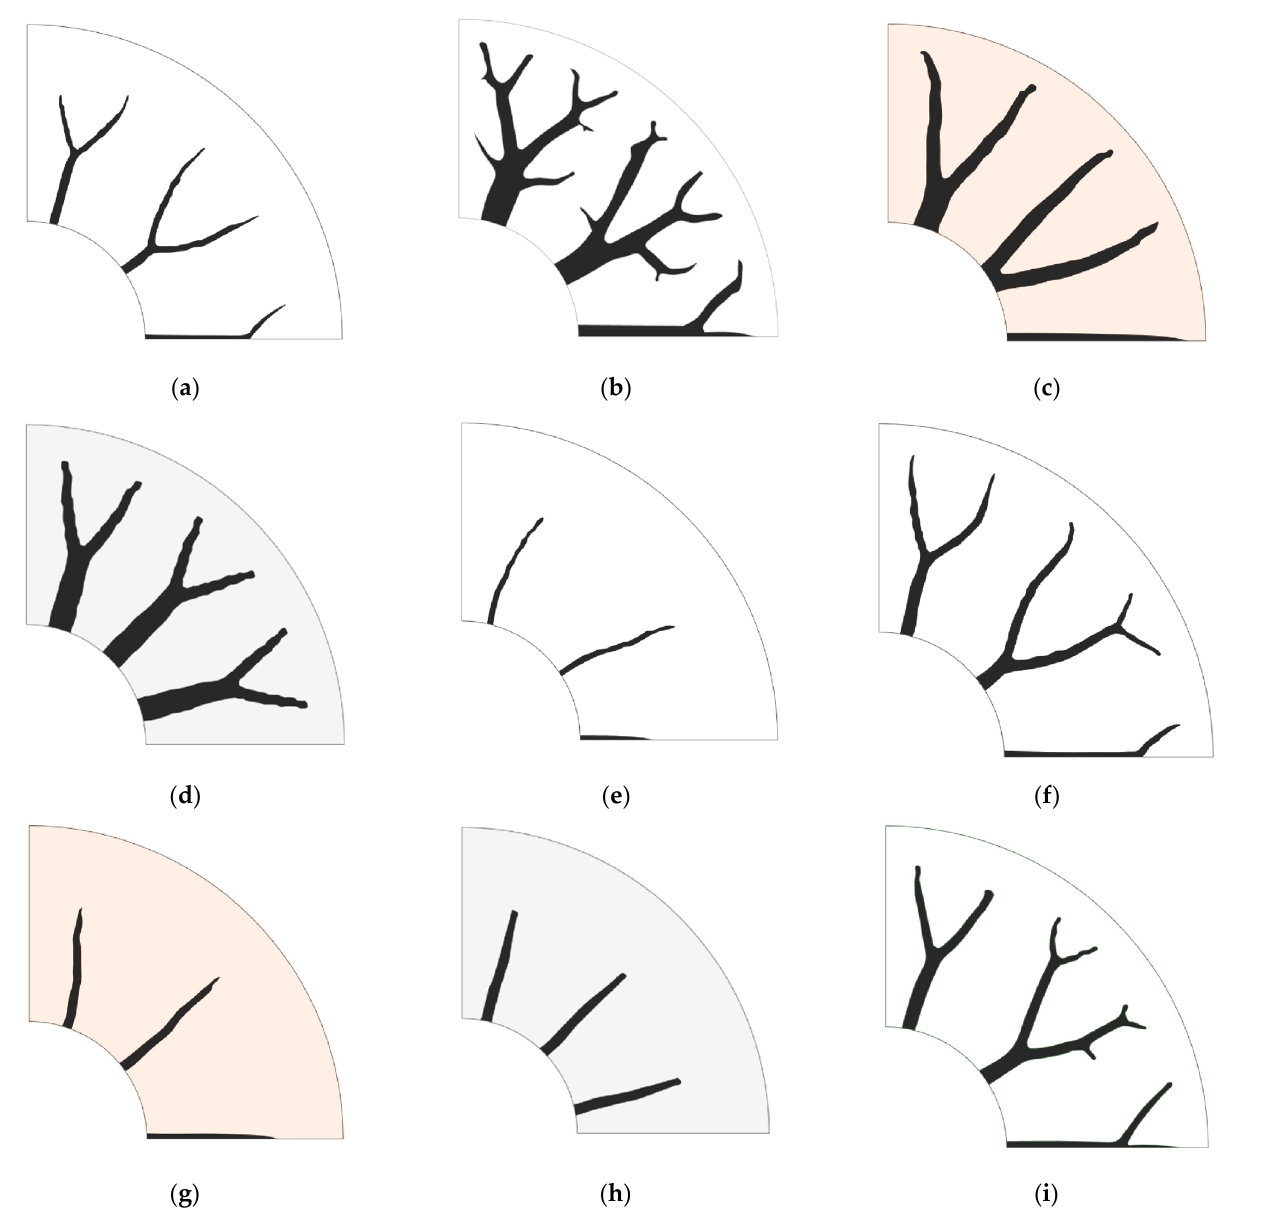
Figure 6. Topology optimization structure of thermal energy storage units. ( a ) No.5 TOCF5%; ( b ) No.6 TOAF21%; ( c ) No.7 TOAF13.7% + CF98%; ( d ) No.8 TOAF16.8% + AF95%; ( e ) No.11 TOCF2%; ( f ) No.12 TOAF8.4%; ( g ) No.13 TOAF3.1% + CF98%; ( h ) No.14 TOAF3.6% + AF95%; ( i ) No.16 TOCF10%.